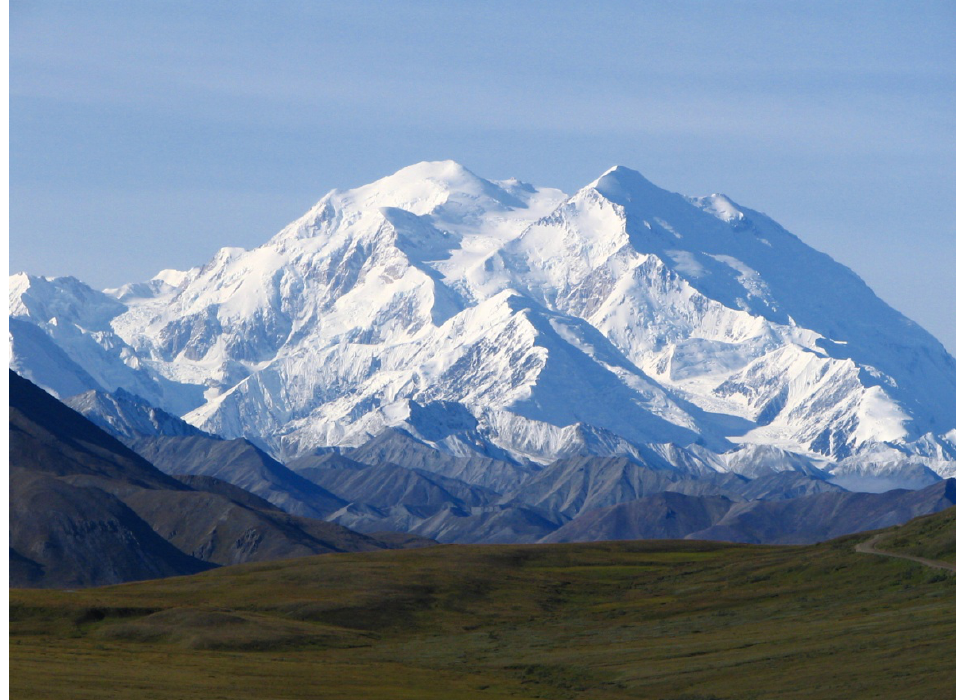
Figure 1. The highest peak in the United States, the name Denali comes from the Koyukon Athabaskan language for “The High One.” The mountain has an elevation of 20,320 feet (6,194 m) above sea level (Image Source: